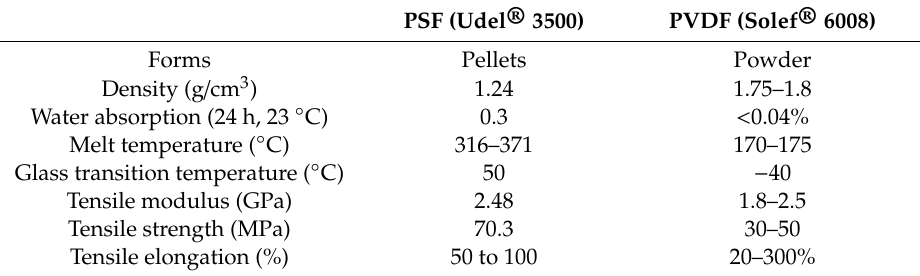
Table 1. Polysulfone (PSF) and polyvinylidene fluoride (PVDF) properties (source: datasheet provided by Solvay website).